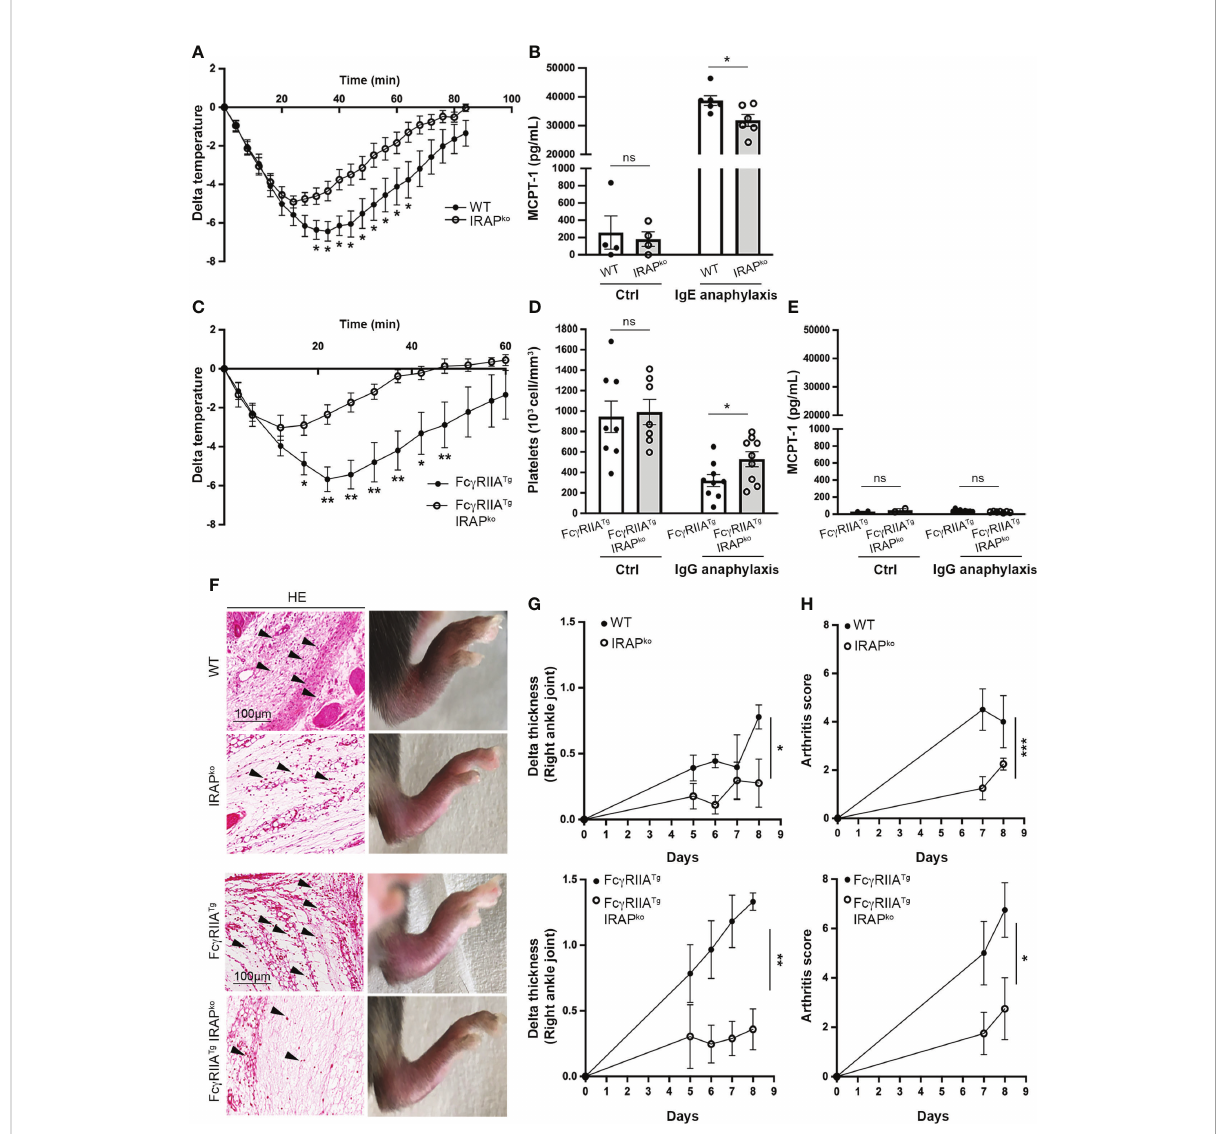
FIGURE 1 IRAP-de fi cient mice show less severe IgE- and IgG-induced anaphylactic reactions and experimental arthritis. (A) 24h after sensitization with anti-DNP IgE wild-type ( WT) and IRAP-de fi cient (IRAP KO ) mice were challenged with antigen (DNP-HSA) to induce passive systemic anaphylaxis (PSA). The drop in body temperature was evaluated. Data presented are the mean ± s.e.m. with 9 mice (pooled from 3 experiments). (B) Released serum MCPT-1 chymase collected at the end of temperature measurements was evaluated in the two groups of mice as well as in unsensitized control mice. (C) WT Fc g RIIA Tg and Fc g RIIA Tg IRAP KO mice were immunized with rabbit IgG and 7 days later mice were challenged with rabbit IgG to induce active systemic anaphylaxis (ASA). The drop in body temperature was evaluated. Data are presented as mean ±